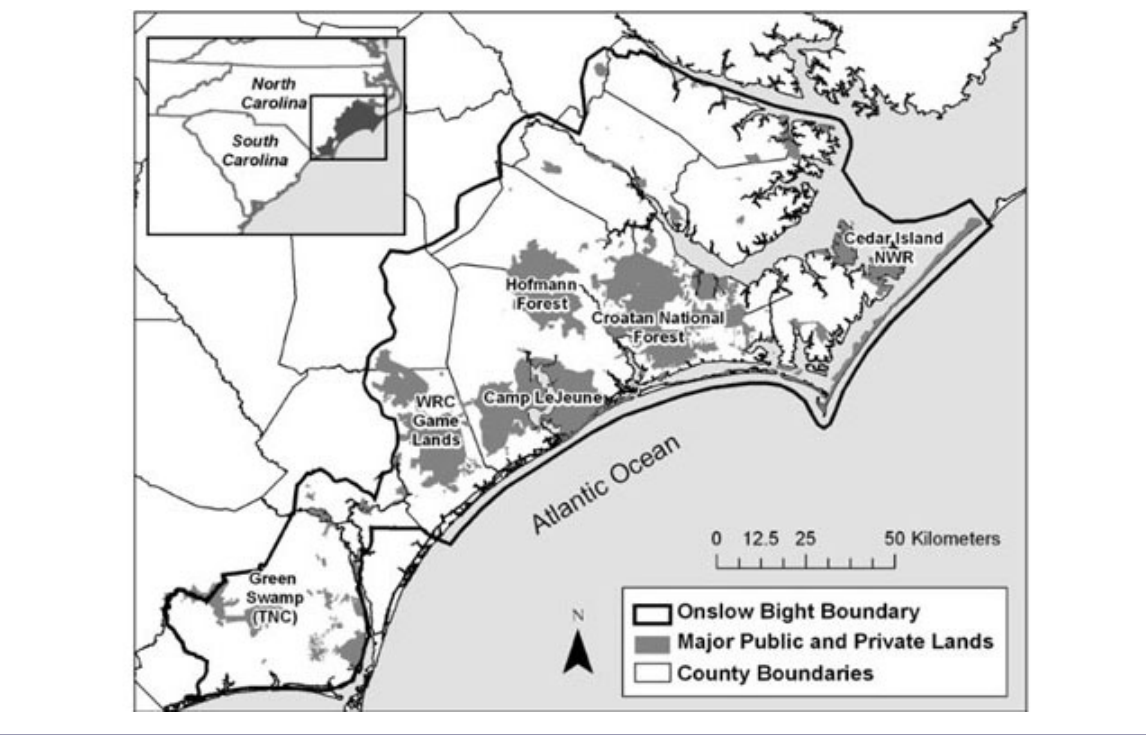
Fig. 1. The Onslow Bight landscape. TNC stands for The Nature Conservancy, WRC is the North Carolina Wildlife Resources Commission, and NWR means National Wildlife